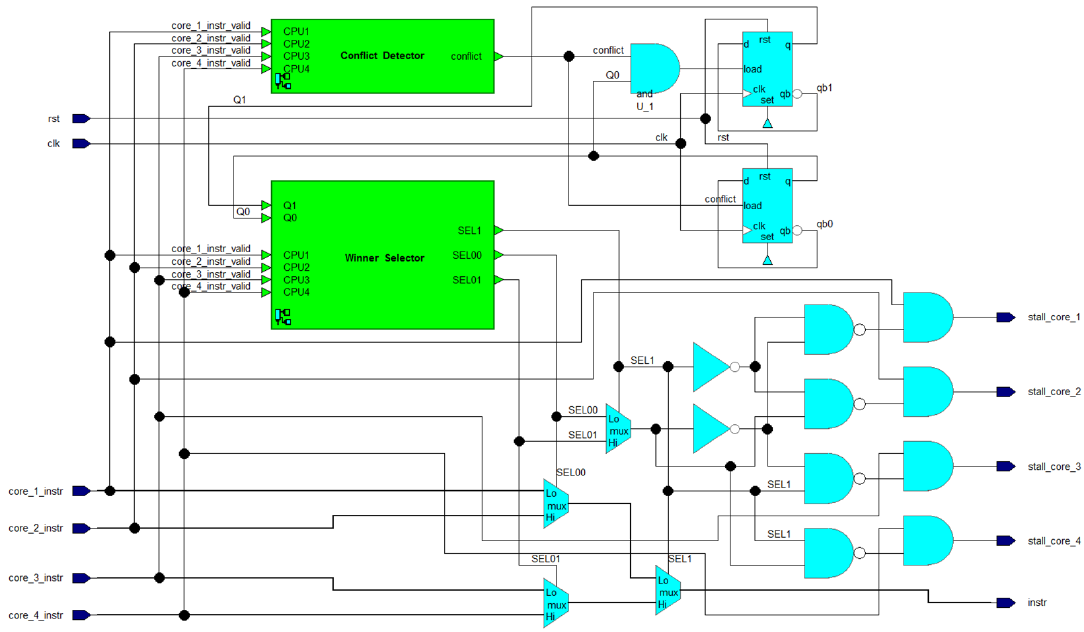
Figure 4. Block diagram of Semaphore module.